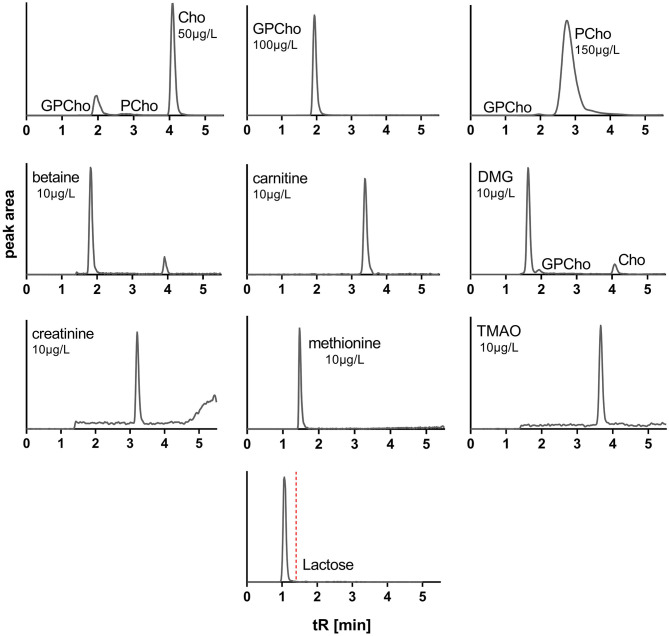
Extracted ion chromatograms of standards of water-soluble forms of choline and related metabolites and lactose. Cho, choline; GPCho, glycerophosphocholine; PCho, phosphocholine; DMG, dimethylglycine; TMAO, trimethylamine N-oxide; tR, retention time. MRM cross talk between analytes is observable but does not interfere.